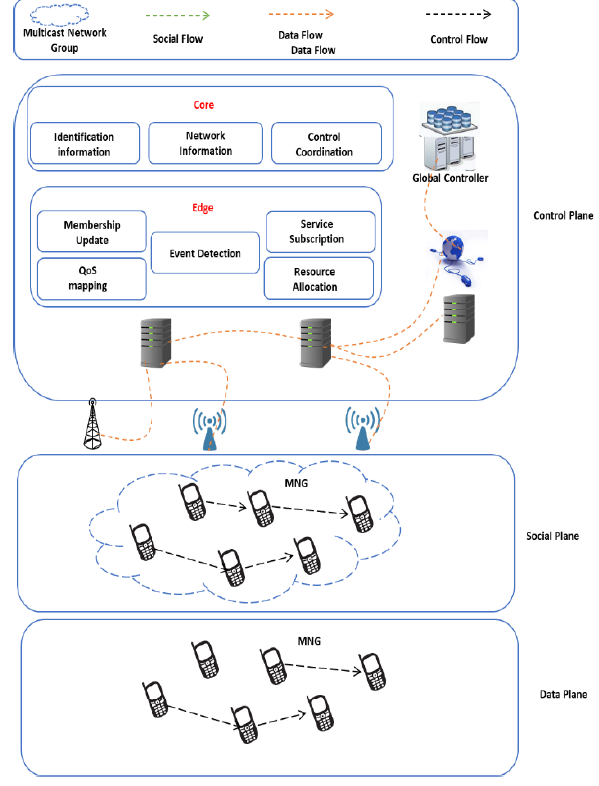
Figure 2. 5G-SDMN MEC-Supported